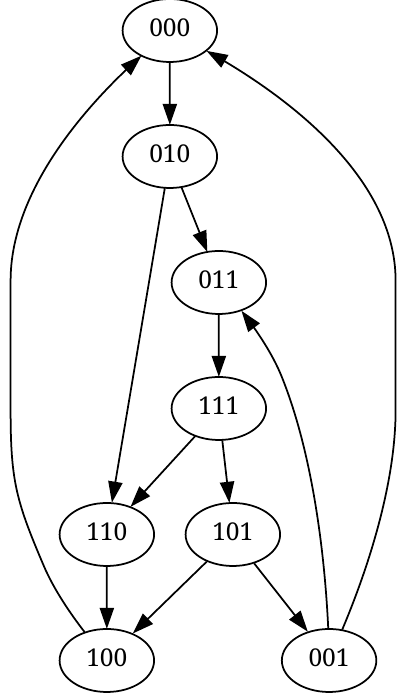
Figure 2 – Fully-asynchronous dynamics of the example BN for